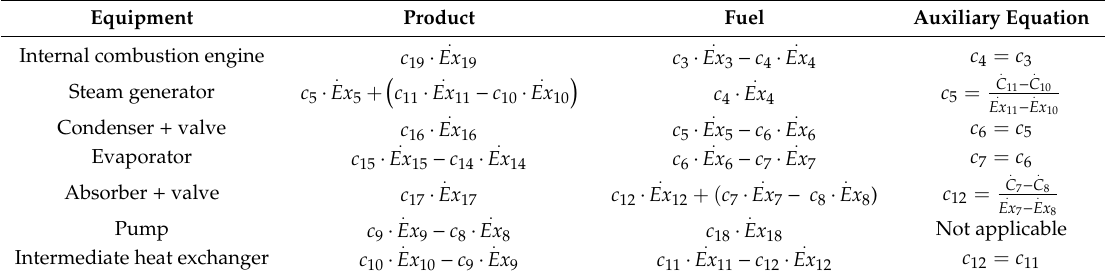
Table 2. Exergoeconomic balances (Specific Exergy Costing, SPECO) for each equipment of the system.